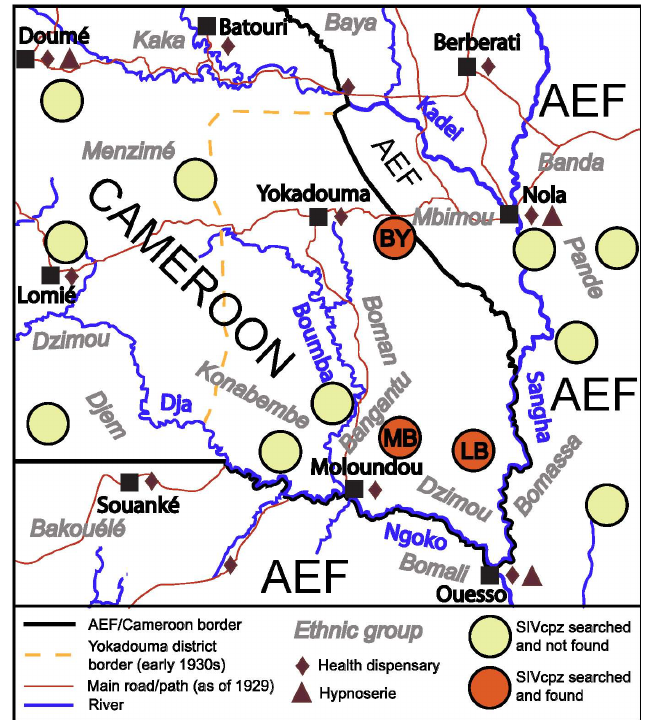
Figure 1. The region of southeast Cameroon and neighboring Afrique Équatoriale Française (AEF) regions circa 1930. Sources: (1) on the SIV surveys: [2,13,15]; (2) on other elements: